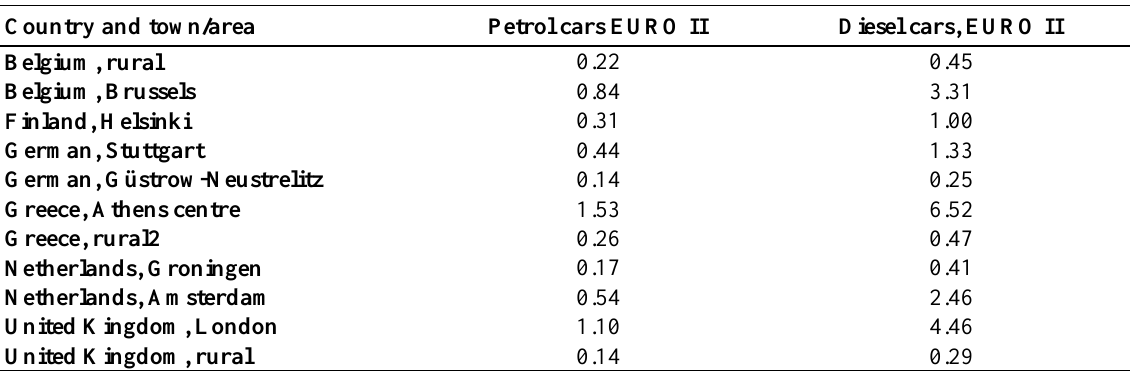
Table 5. Damage cost in €/100 vkm Country and